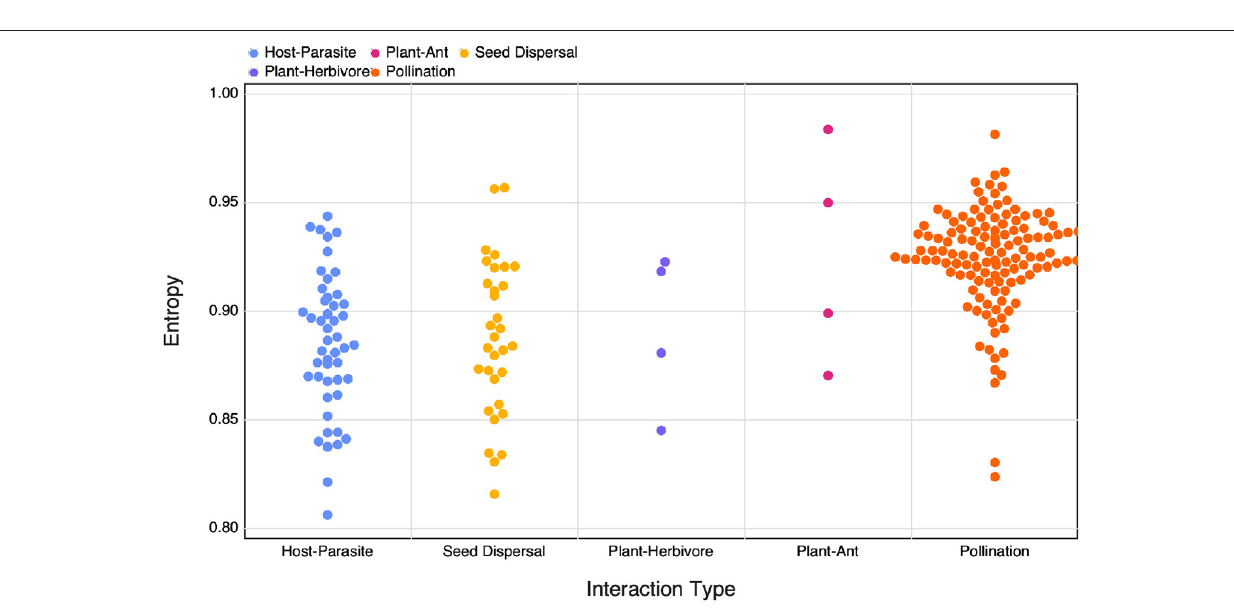
FIGURE 4 | The calculated SVD entropy of different interaction networks of different interaction